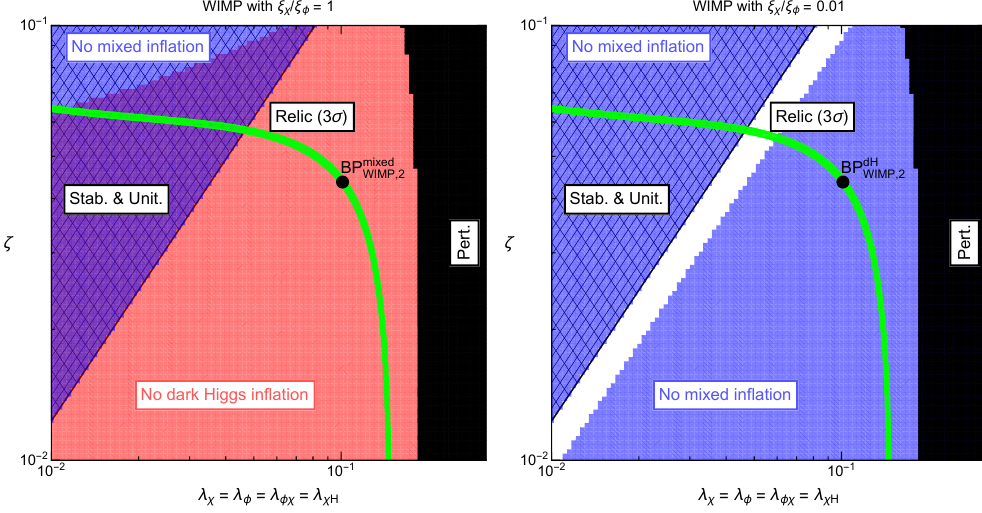
Figure 2 . Parameter space for WIMP dark matter scenario with (cid:24) (cid:31) =(cid:24) (cid:30) = 1 (left) and 0 : 01 (right) for the quartic couplings with (cid:21) (cid:31) = (cid:21) (cid:30) = (cid:21) (cid:30)(cid:31) = (cid:21) (cid:31)H versus the dark matter cubic coupling (cid:16) . The rest input parameters and color codes are as in (cid:12)gure 1, except that (cid:16) is varying.